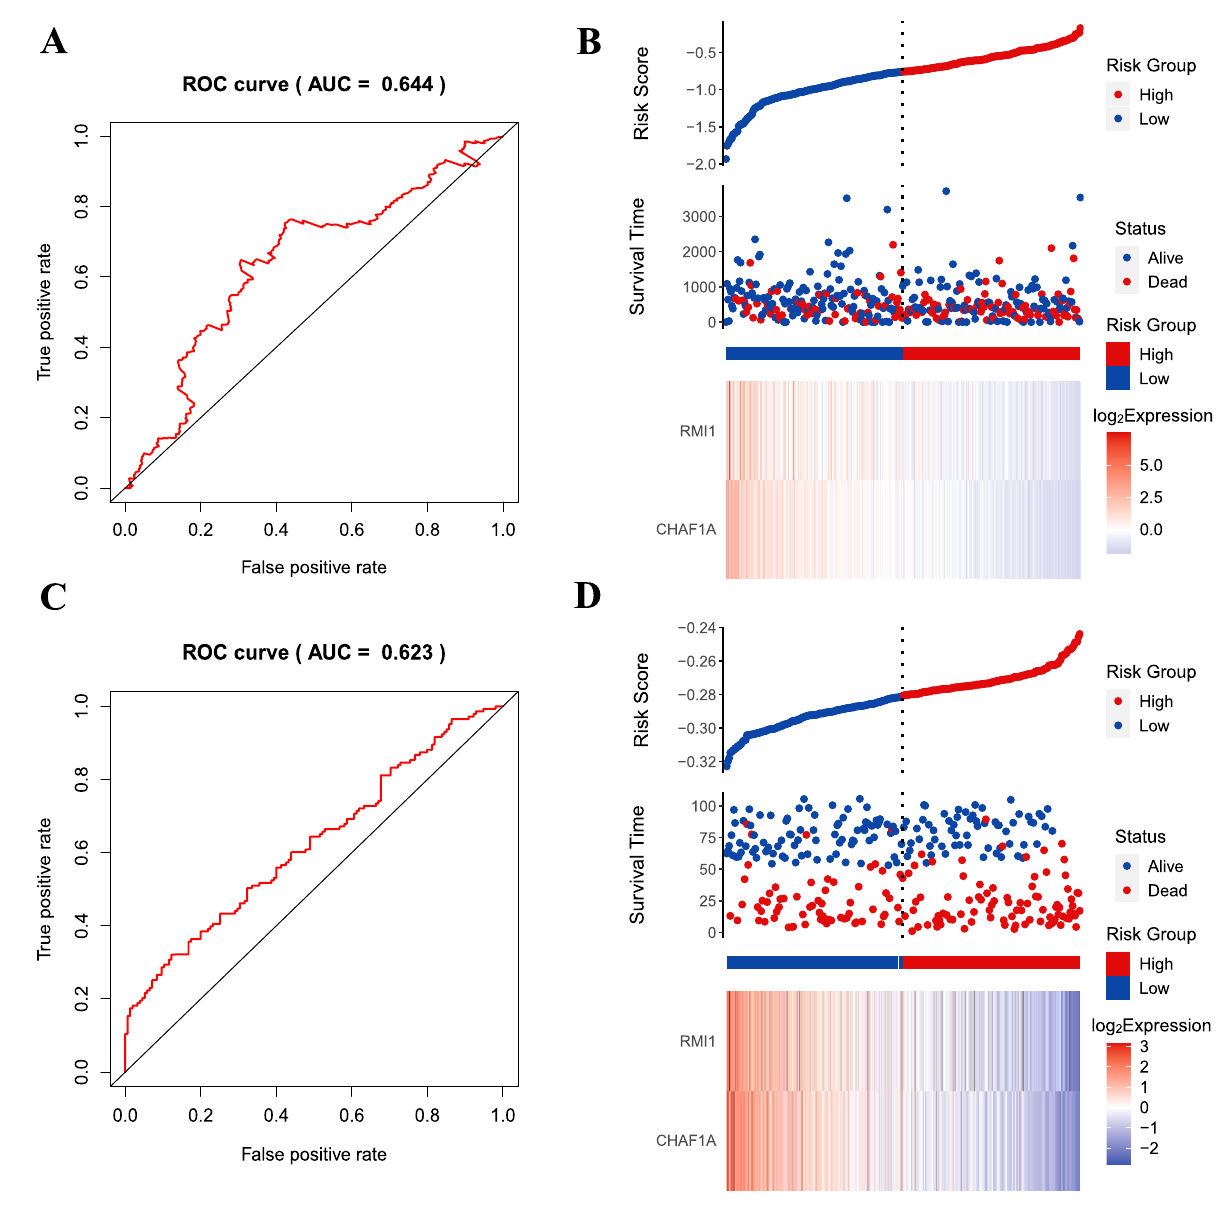
Figure 3. Prognostic value of the two genes signature for prediction of overall survival of patients with GC. ( A ) ROC curve analysis for predicting survival in patients with GC according to the risk score in the TCGA cohort; ( B ) From top to bottom are the risk score, patients’ survival status distribution, and the expression heat map of two genes in the low- and high-risk groups in the TCGA cohort; ( C ) ROC curve analysis for predicting survival in patients with GC according to the risk score in the GSE66229 cohort; ( D ) From top to bottom are the risk score, patients’ survival status distribution, and the expression heat map of two genes in the low- and high- risk groups in the GSE66229 cohort. A heat map was generated using the “pheatmap” package (version 1.0.12; https:// cran.r- proje ct. org/ web/ packa ges/ pheat map/ index. html) of the R software (version